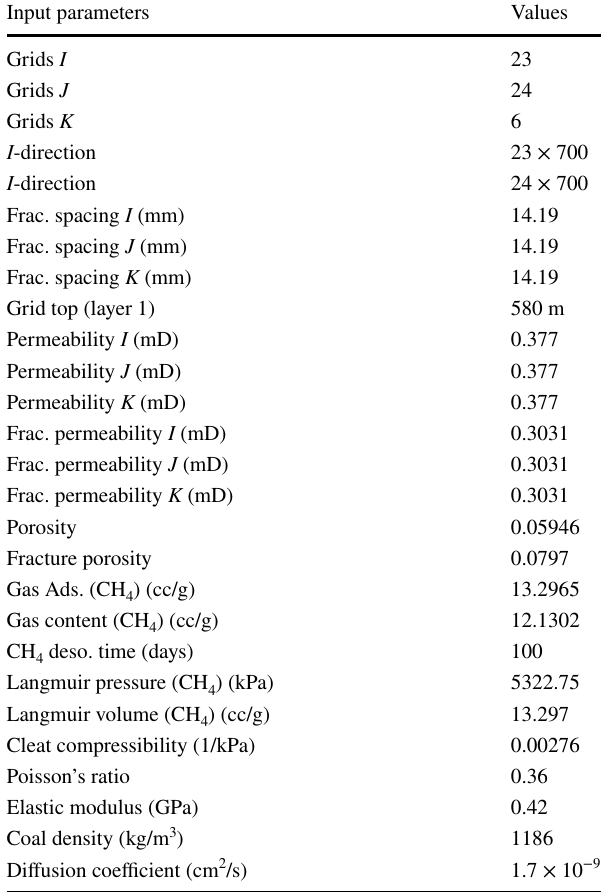
Table 2 Initial parameter settings in base